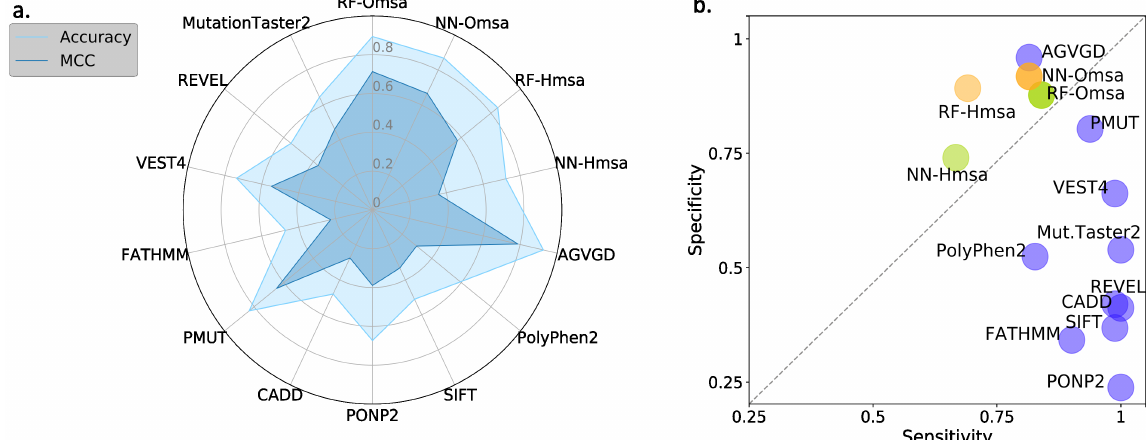
Figure 8. Performances of the standard pathogenicity predictors for the BRCA1 variants, described using four standard parameters: ( a ) Accuracy/MCC, and ( b ) sensitivity/specificity. Here, we compare the performances of ten well-known pathogenicity predictors with that of a family of RF and NN predictors for BRCA1. The RF/NN predictors were derived for this study using the five properties employed to characterize the variants and a set of BRCA1 variants with known pathogenicity annotations (see Materials and Methods). We added Hmsa and Omsa to their names to indicate the origin of the msa utilized to compute the conservation-based properties.